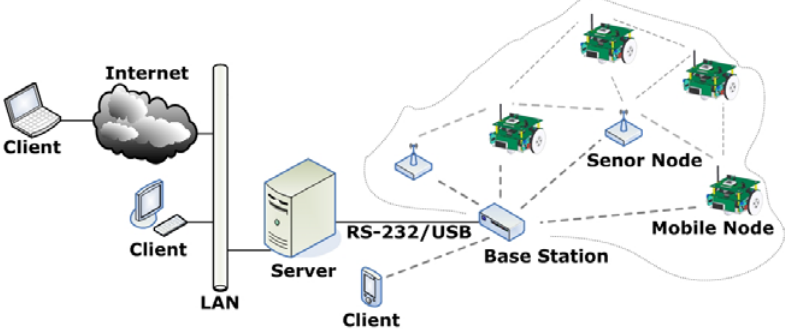
Figure 1. The system architecture of a mobile sensor